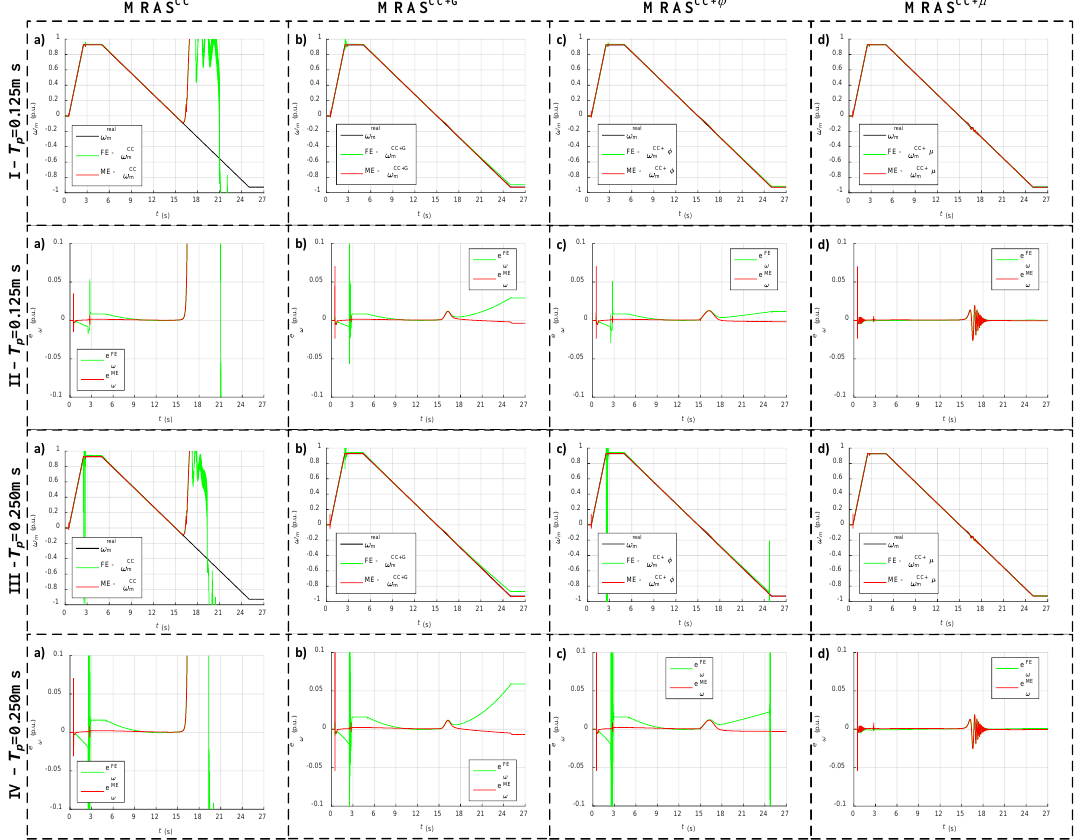
Figure 11. Slow speed reversal for four tested MRAS CC -type estimators: classical MRAS CC —column ( a ), MRAS CC+ G —column ( b ), MRAS CC+ ϕ —column ( c ), MRAS CC+ µ —column ( d ) for two sampling times: T p = 0.125 ms (row I, II), T p = 0.250 ms (row III, IV) and numerical methods (FE and ME): speed transients (row I and III), speed estimation error transients (row II and IV)—simulation results, m L = m LN .